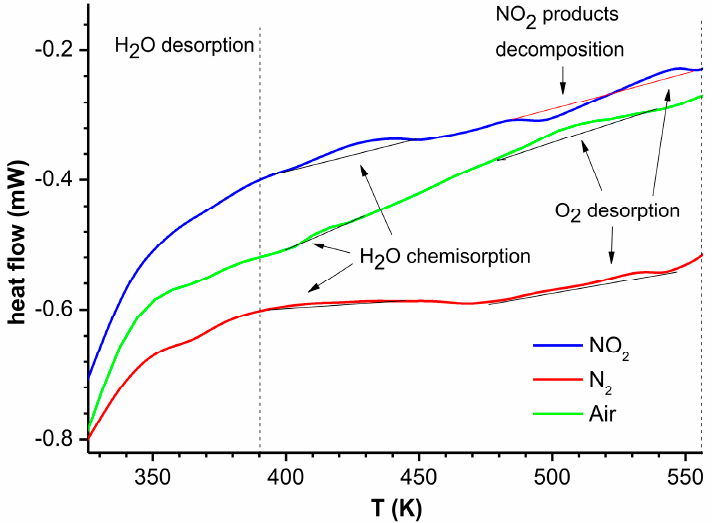
Figure 5. Results of DSC analysis for the heating of ZnO nanostructures heated to 300 °C in nitrogen ( red line ), air ( green line ) and after the contact with NO 2 at RT ( blue line ).